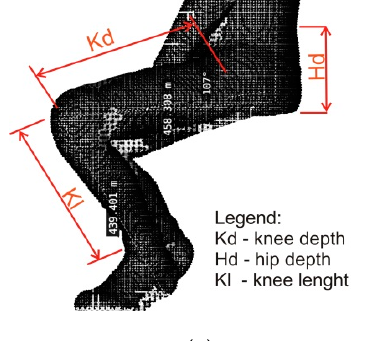
( b ) Figure 7. Determining the dimensions of the protector applied to the material ( a ); and the distance between protector elements ( b ). Since textile materials of higher strength are commonly used in the production of protective garments resulting from the greater thickness and density of the textile mate- rial, it is necessary to consider the possibility of applying design solutions that allow for the better incorporation of textile material into 3D printed individualized protective el- ements. The application of 3D printed shapes in garments can thus be increased. The construction solution shown in Figure 8 is proposed for this purpose. The construction of the garment is adapted to the body in the sitting position. The entire process of garment construction is also adapted to the technical performance of 3D printing.